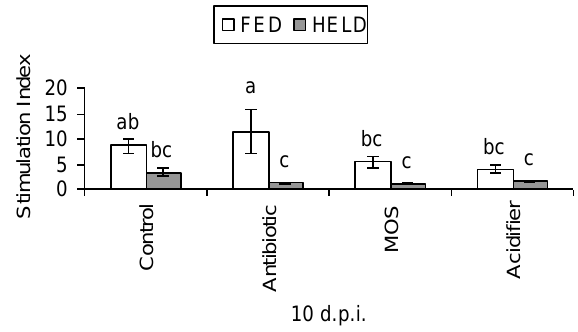
Figure 2. Effects of post hatch holding time and dietary supplements on T-cell proliferation of broilers 10 days post infection (d.p.i.) when stimulated with different levels of Con A, expressed by Stimulation Index (Mean values, n = 6; error bars indicate SEM; bars without a common superscript differ significantly).